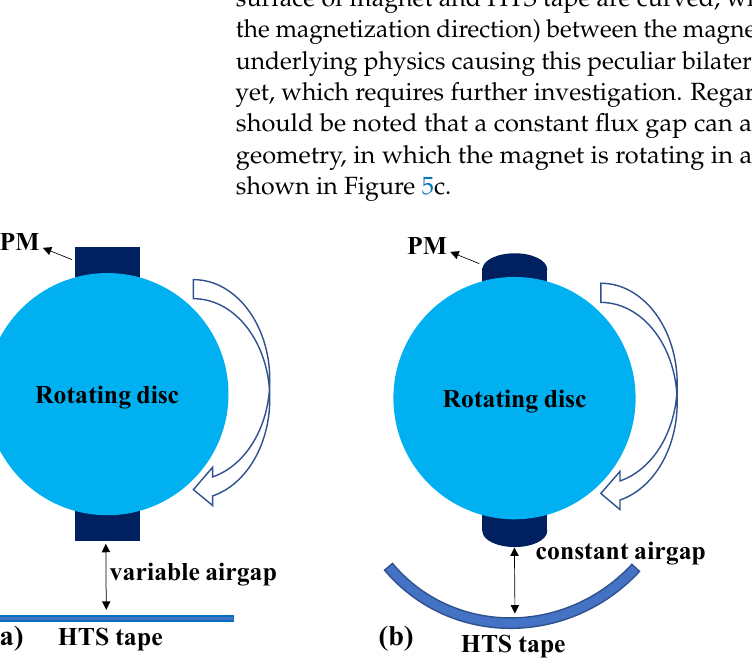
Figure 5. Cross section diagram for different HTS dynamo configurations: ( a ) axial flux geometry with non-uniform airgap, ( b ) axial flux geometry with uniform geometry, ( c ) radial flux geometry with uniform airgap (the rotating plane is perpendicular to the paper).